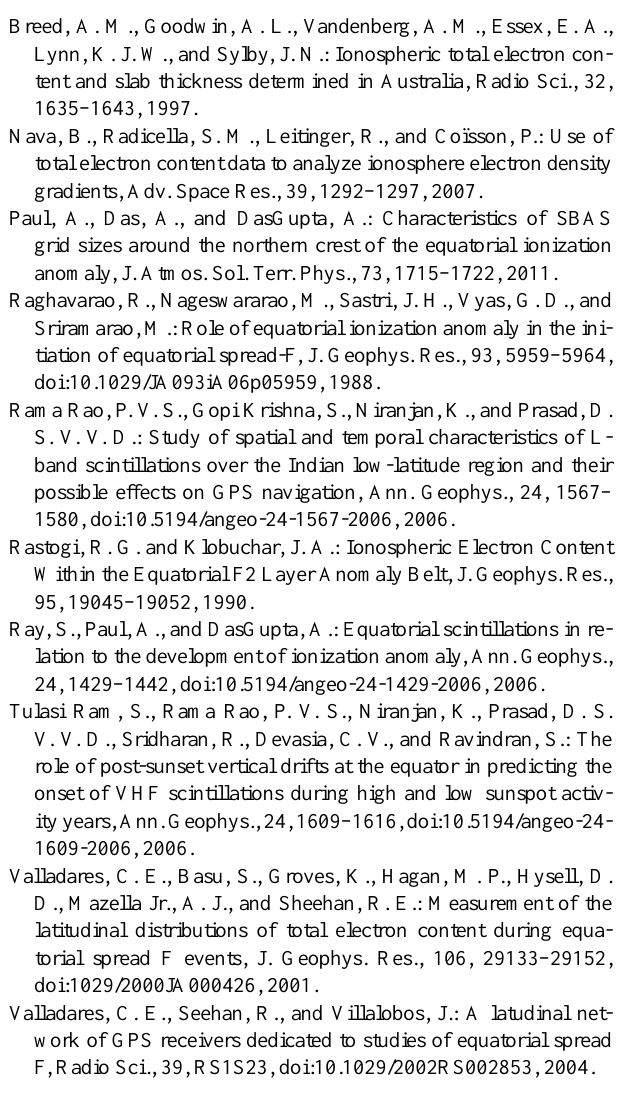
Table 4. 2 × 2 contingency table of the three stations (Calcutta, Farakka, N.B.U. Siliguri) for testing the null hypothesis during